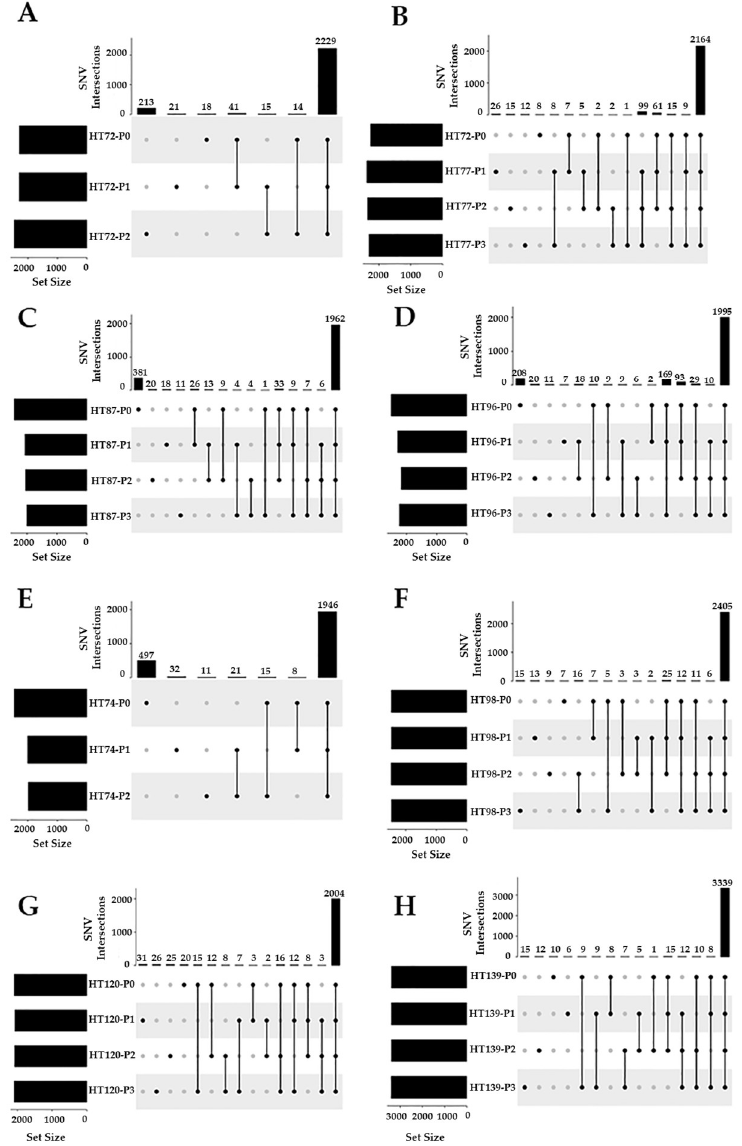
Figure 7. UpSet plots of SNVs indicating the intersection size of SNVs between P0 and their corre- sponding passages. The majority of the SNVs were retained following serial passaging. ( A ) HT72 (OS), ( B ) HT77 (OS) , ( C ) HT87 (OS) , ( D ) HT96 (OS) , ( E ) HT74 (RMS) , ( F ) HT98 (Wilms tumor), ( G ) HT120 (Wilms tumor), and ( H ) HT139 (Wilms tumor). The intersection size refers to the frequency of the combination depicted below the bar [80]. The set size corresponds to the frequency of associations [80] with P0 and its subsequent PDX passages.